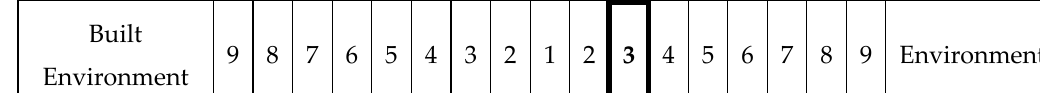
Table 3. Pairwise comparison between Built Environment and Environment Cluster.